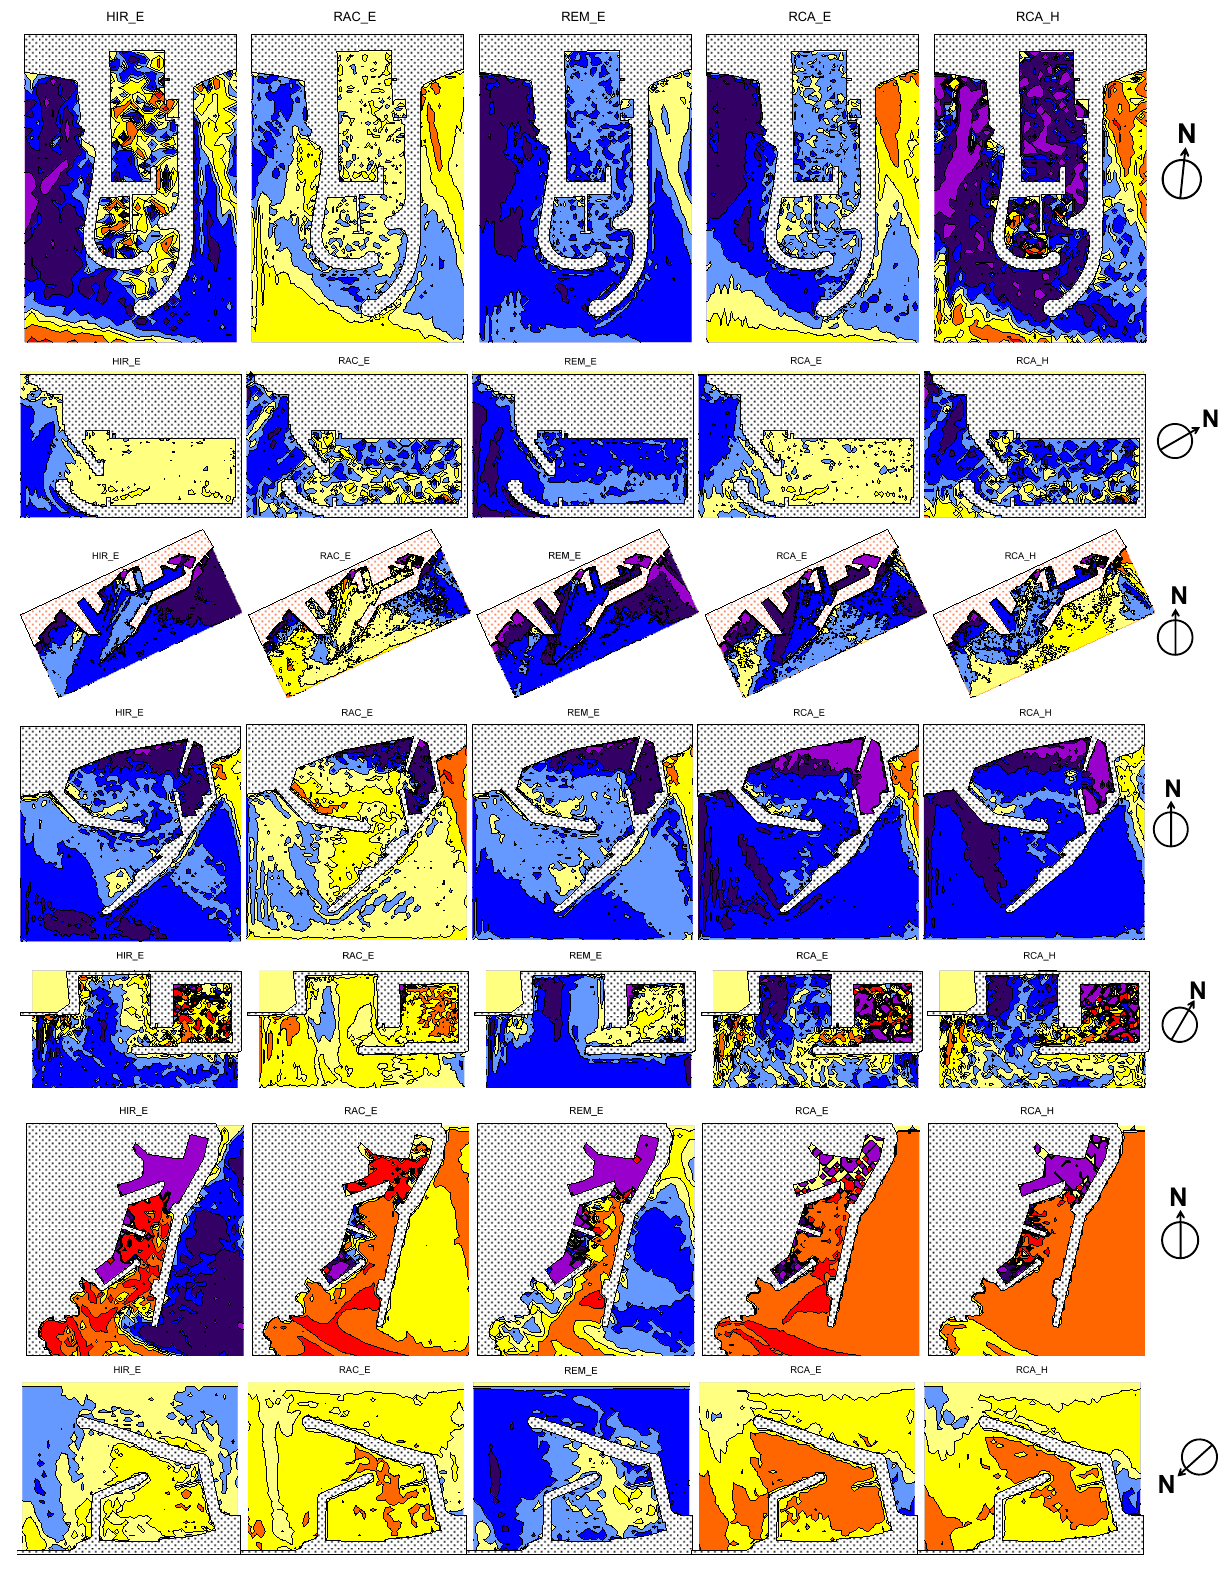
Figure 3. Projected change (future minus present in %) of H s at the studied ports. Panels from left to right: results for HIR_E, RAC_E, REM_E, RCA_E and RCA_H models. Panels from top to bottom: Segur de Calafell, Torredembarra, Tarragona, Cambrils, L’Hospitalet de l’Infant, L’Ametlla de Mar and Cases